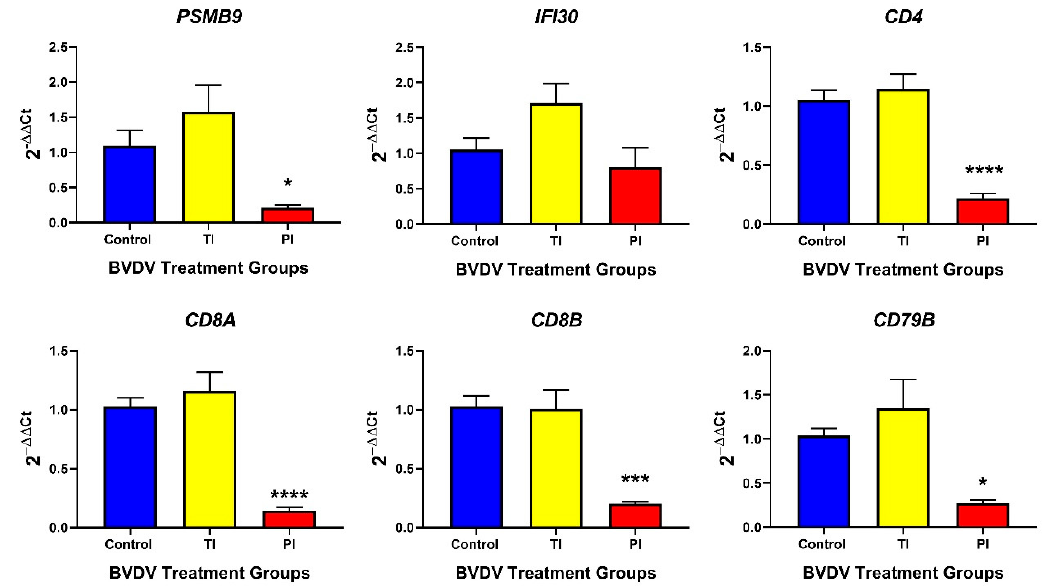
Figure 3. Thymic (Control, TI, and PI) transcript expression associated with the adaptive immune response. No significant differences were found in TI fetal thymuses compared to controls. However, all adaptive genes, with the exception of IFI30 , were significantly down-regulated in PI fetal thymuses compared to controls. TI: Transiently Infected, PI: Persistently Infected. * p < 0.05, *** p < 0.001, **** p < 0.0001.